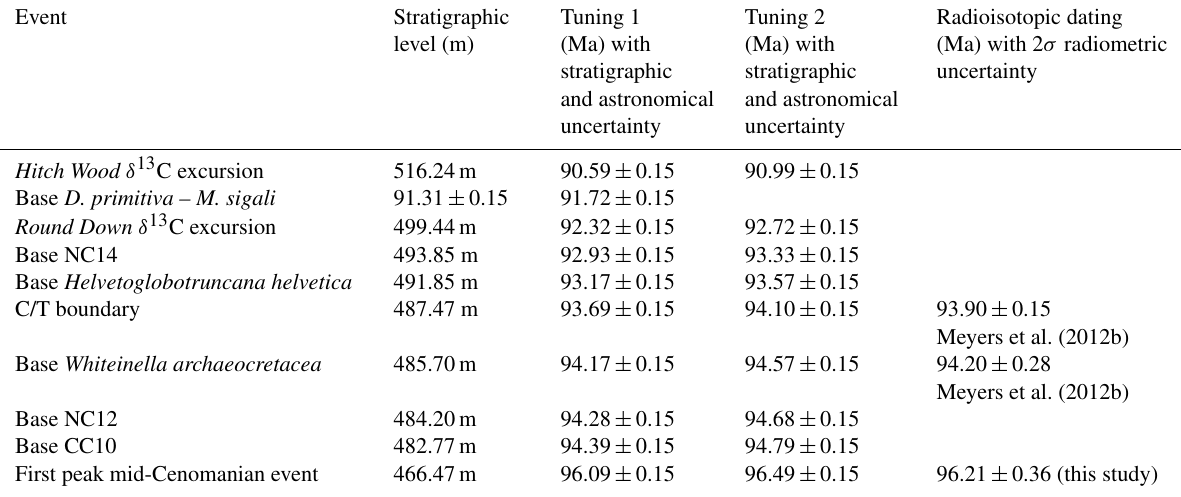
Figure 2. Phase relationship between eccentricity and proxy records. During eccentricity maxima, the seasonal contrast for the NH is maximally enhanced during precession minima and maximally reduced during precession maxima (top: schematic representation of the Earth’s orbit around the Sun). Hence, climate variability is strongly amplified during eccentricity maxima, triggering the highest variability in the climate-sensitive records and hierarchical organization of chert–limestone alternations. Table 1. Astronomical tuning options for biostratigraphic and isotopic events and comparison to radioisotopic ages. Uncertainties on tuned absolute ages comprise the uncertainty in the stratigraphic position and/or correlation of an event ( ± 0.75m) and the uncertainty in the astro- nomical target curve (Laskar et al., 2011a) ( ± 0.079Myr). The numerical age of the C/T boundary is based on intercalibration of 40 Ar / 39 Ar dating, U–Pb dating and astrochronology (Meyers et al., 2012b). The radioisotopic age of the base of Whiteinella archaeocretacea is the weighted mean age of single- and multicrystal 40 Ar / 39 Ar ages of bentonite A. Radioisotopic ages for the first peak of the mid-Cenomanian event come from single-crystal 40 Ar / 39 Ar dating of the Thatcher bentonite in the Conlinceras tarrantense zone ( Calycoceras gilberti ). All radioisotopic ages are reported in 2 σ and using an Fish Canyon sanidine age of 28.201 ± 0.046ka (1 σ ) (Kuiper et al., 2008). Event names in italics refer to nomenclature of Jarvis et al.